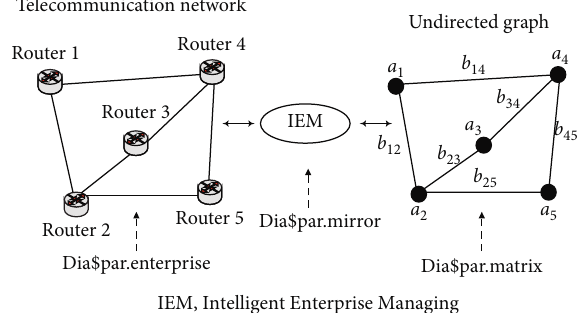
Figure 6: Digital twin creation for telecommunication network.